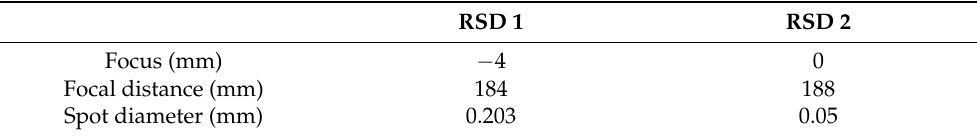
Table 3. Definition of the experimental designs using focal distance as scenario variable.